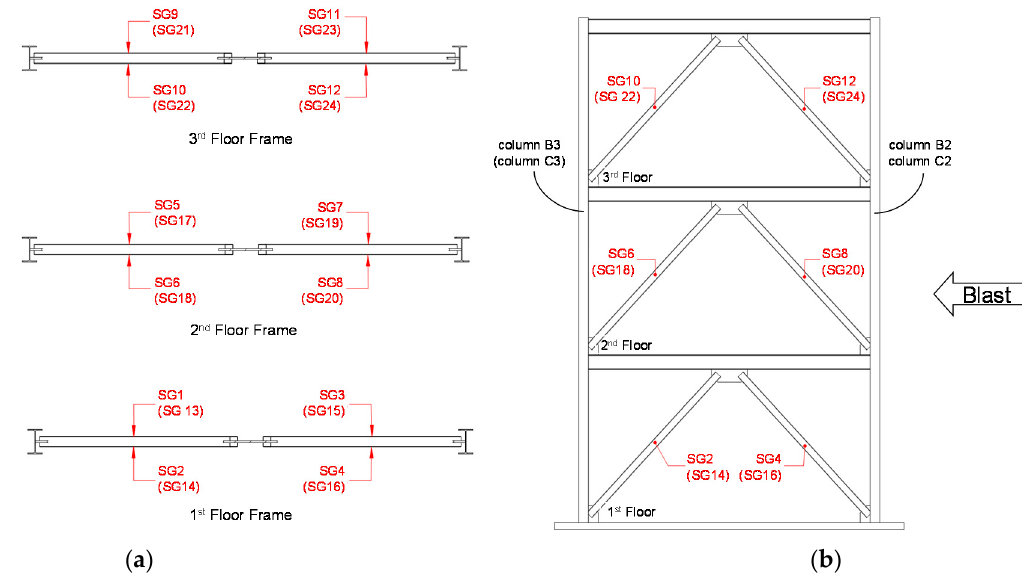
Figure 8. Strain gauge locations on braces along blast direction: ( a ) Plan view of braces per floor; ( b ) Side view of braces; IDs in brackets refer to strain gauges attached on column line C braces.